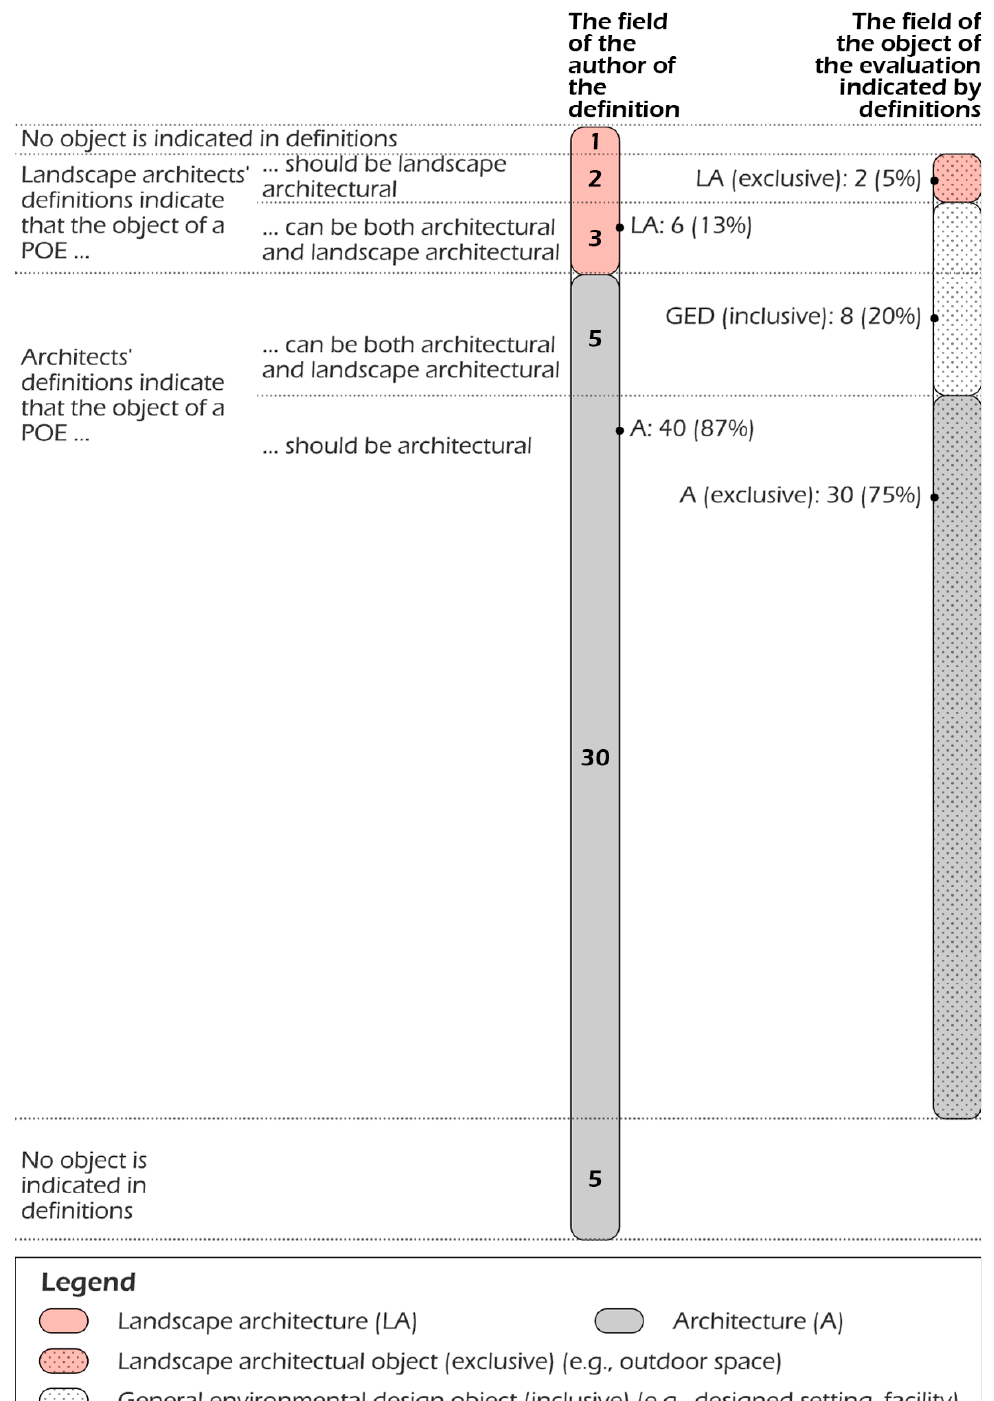
Figure 6. The interrelationship between the field of the definition authors and the field of intended evaluation objects indicated by the authors.